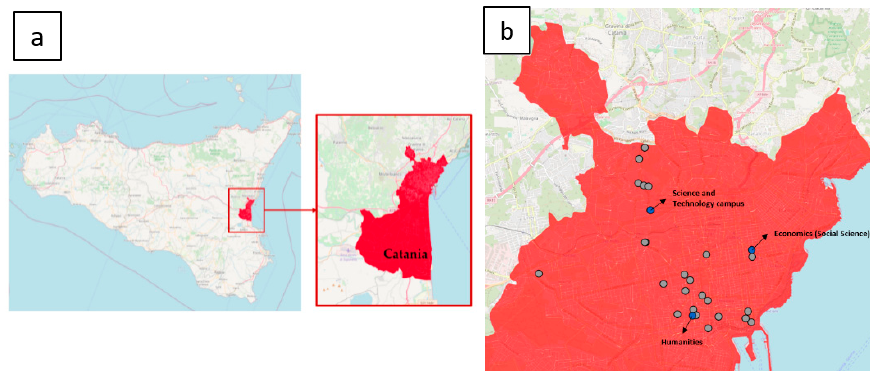
Figure 3. Localization of Catania in Sicily ( a ); map of University sites ( b ).